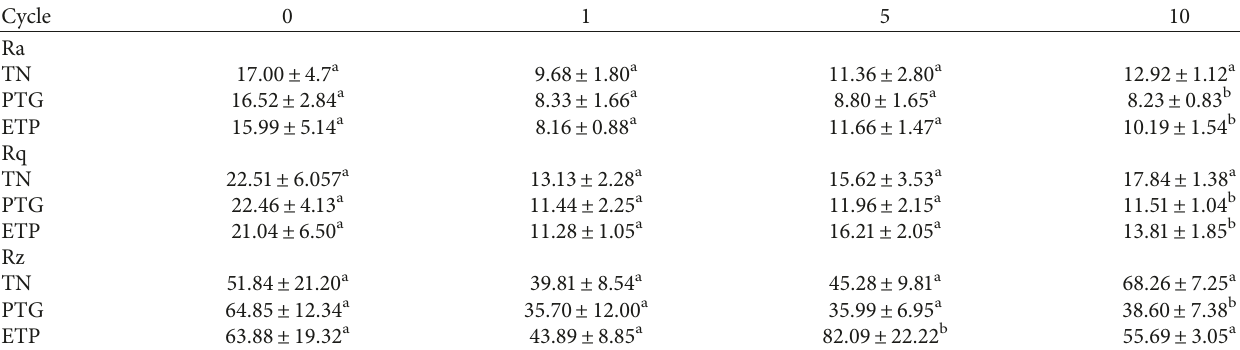
Table 2: Comparison of SR parameters between the instruments (means ± standard deviation).